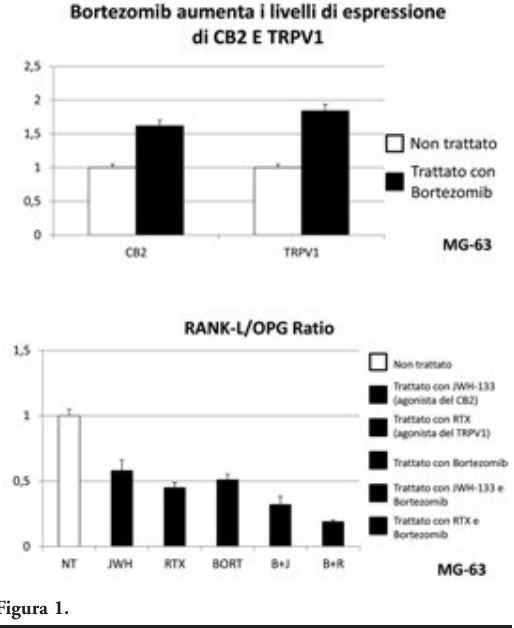
Figura 1. Colture cellulari di MG-63 e HOS sono state trattate con singolarmente o in combinazione. Gli effetti di questi trattamenti su apoptosi, progressione del ciclo cellulare ed espressione di alcuni geni target coinvolti nella proli- ferazione, nella sopravvivenza e nel metabolismo osseo, sono stati valutati mediante saggi